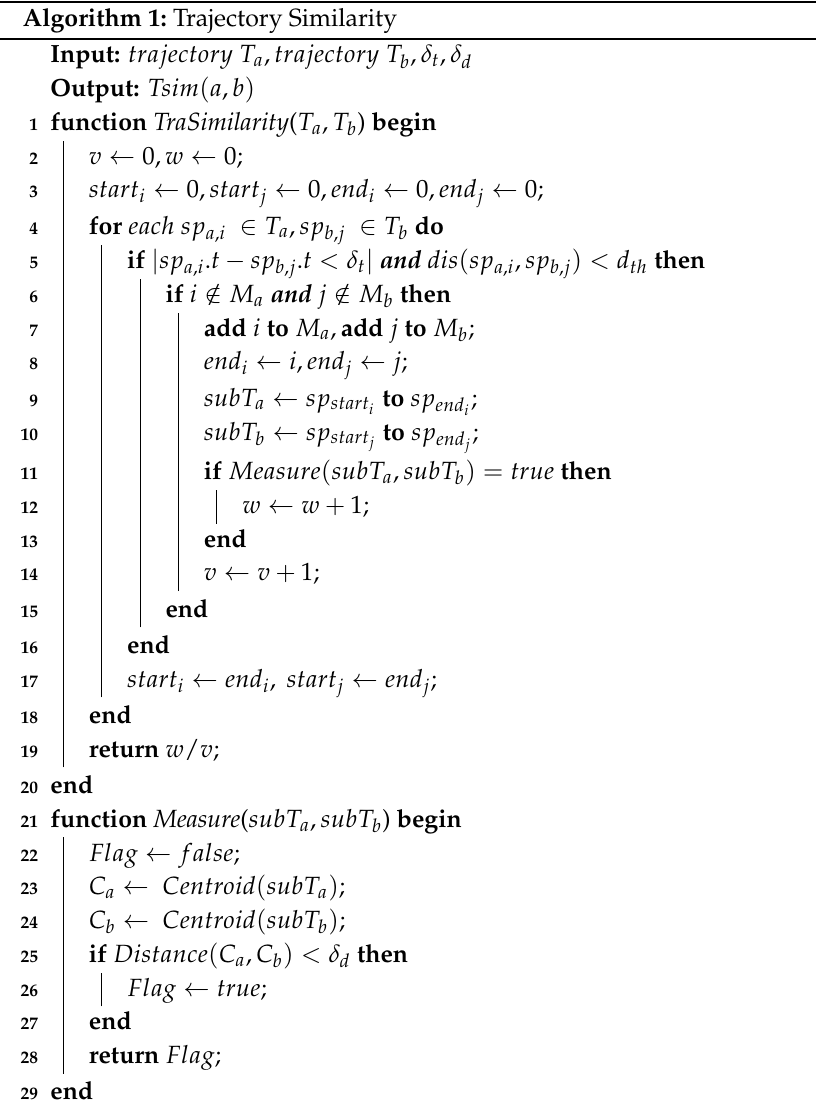
Algorithm 1: Trajectory